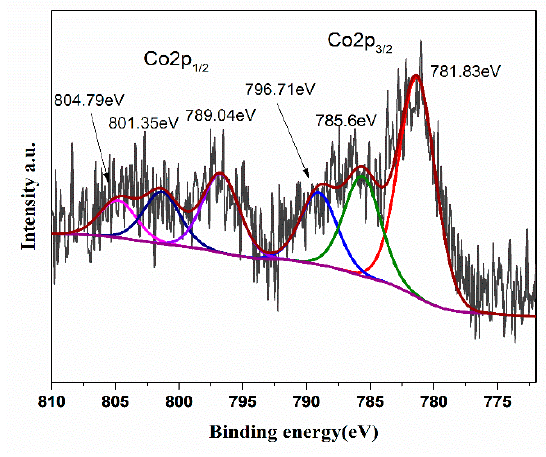
Figure 9. Co 2p peak curve of XPS spectrum of Co-PKEC.